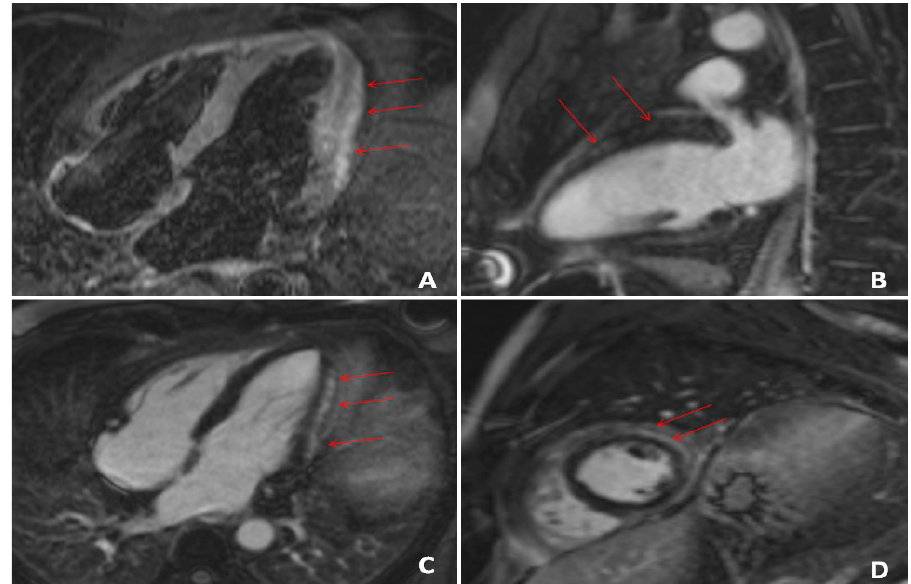
Figure 1. CMR assessment of a COVID-19 patient with elevated troponin levels. ( A ) Edema of the lateral wall in STIR sequences (arrows). ( B ) Non-ischemic subepicardial (arrows) LGE of the anterior wall in 2 chamber view; ( C ) 4 chamber view; ( D ) short axis (extended at 13% of the LV).